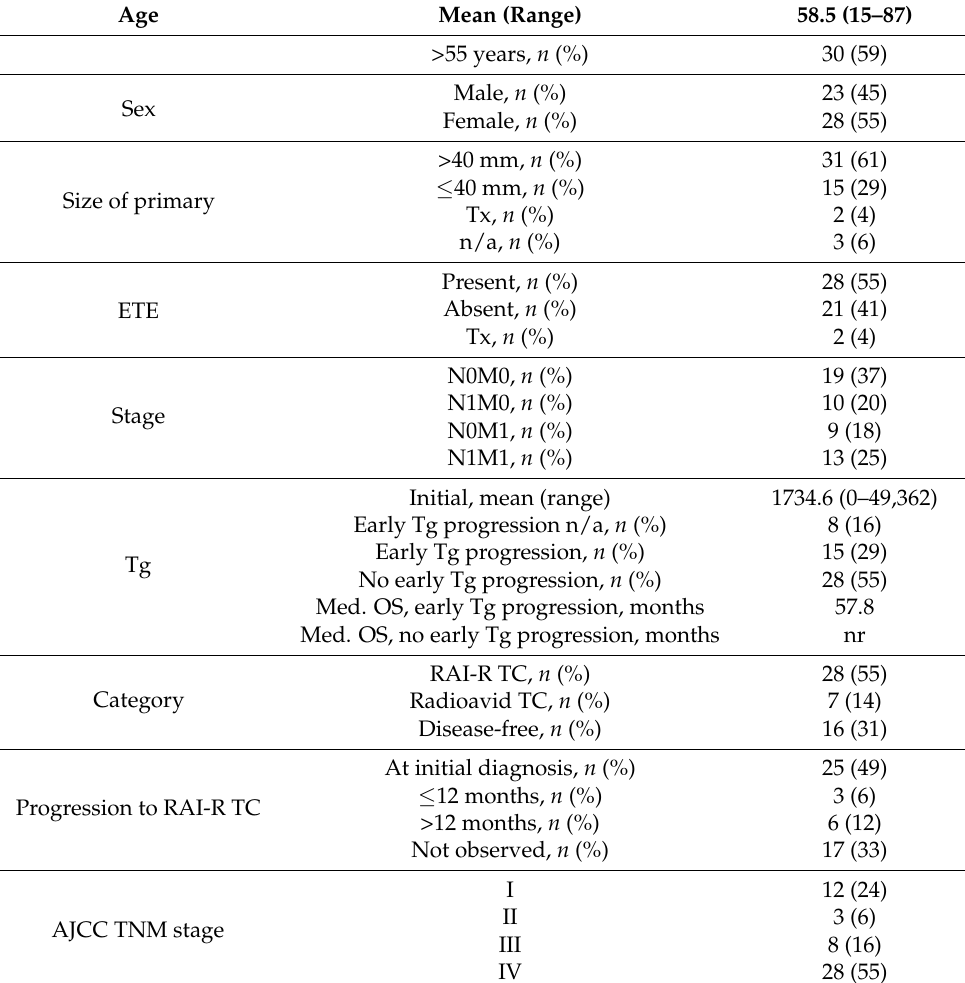
Table 1. Patient characteristics for the assessment of radioiodine refractory (RAI-R) poorly differen- tiated thyroid carcinoma (PDTC) at initial disease and the prognostic factor of early thyroglobulin (Tg)